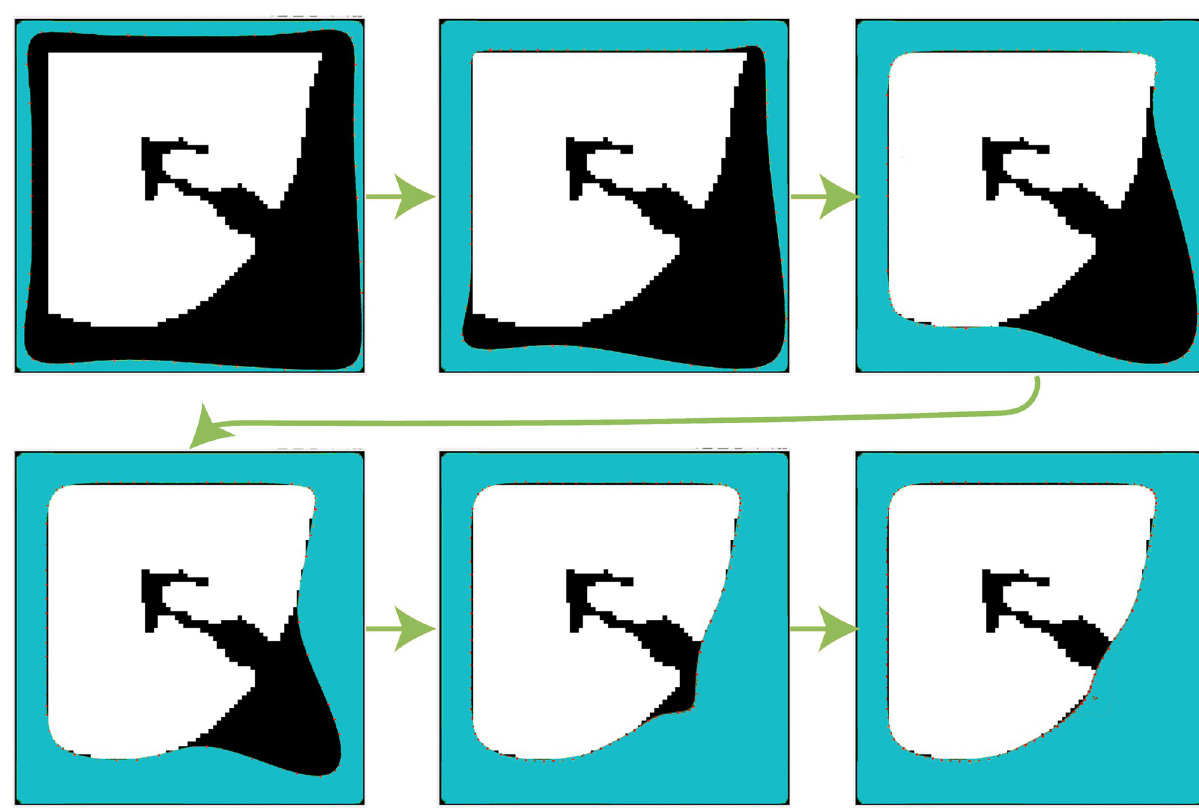
Fig 10. The overall boundary correction process for a local region.